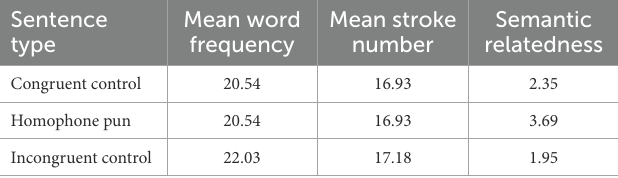
TABLE 2 Properties of context noun used in the three experimental